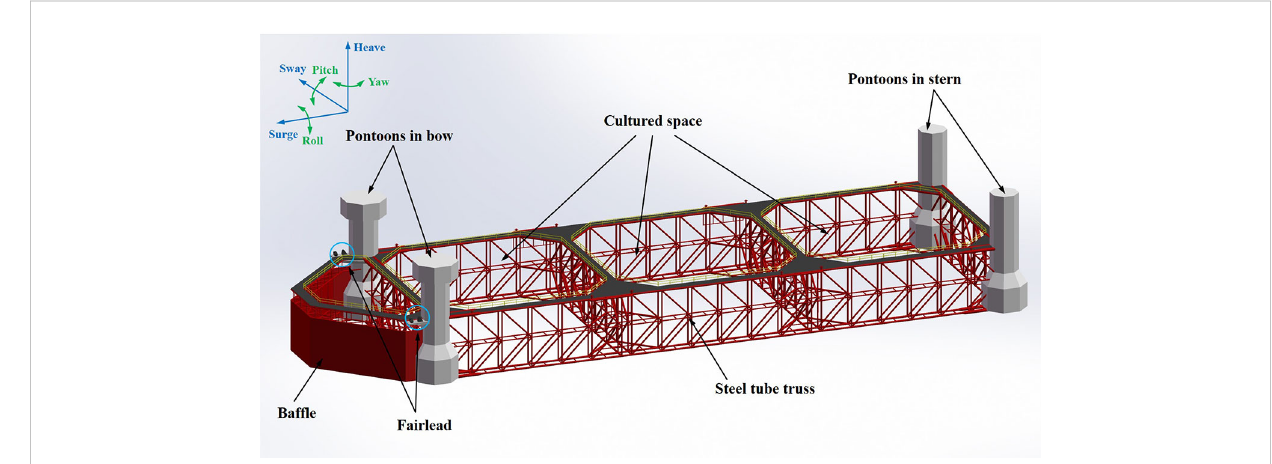
FIGURE 2 Diagram of the new semi-submersible vessel-shape fi sh farm